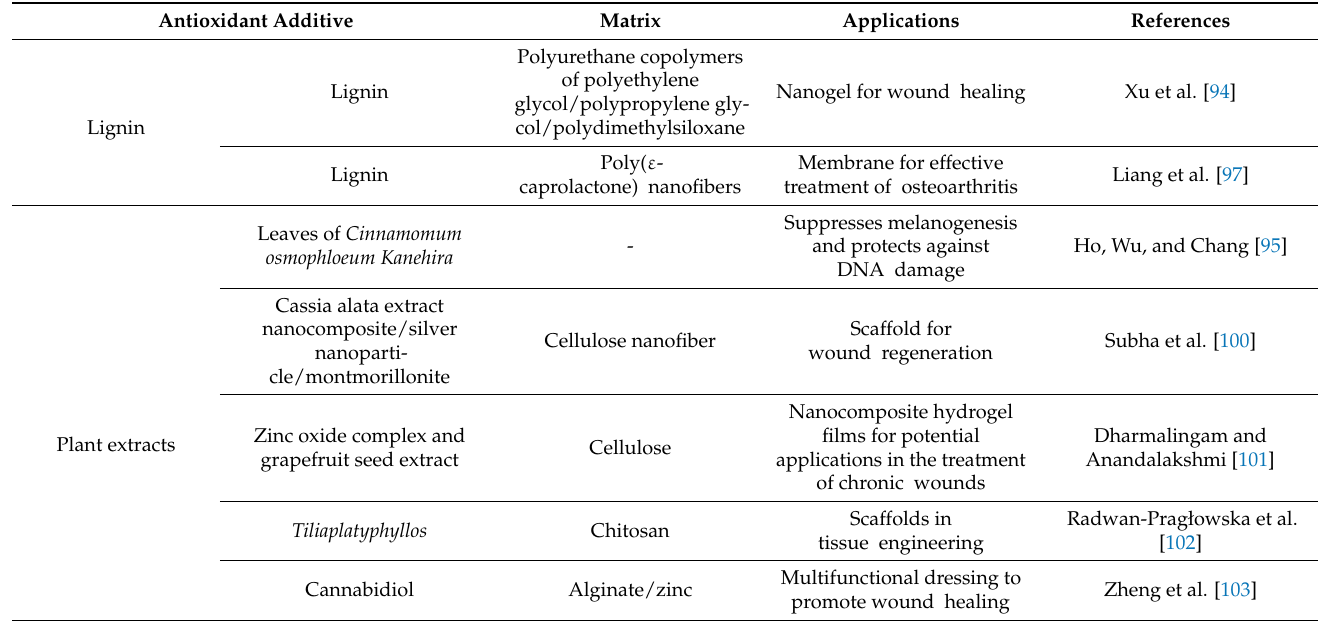
Table 3. Antioxidant biomaterials from different polymer matrices and their applications in the food